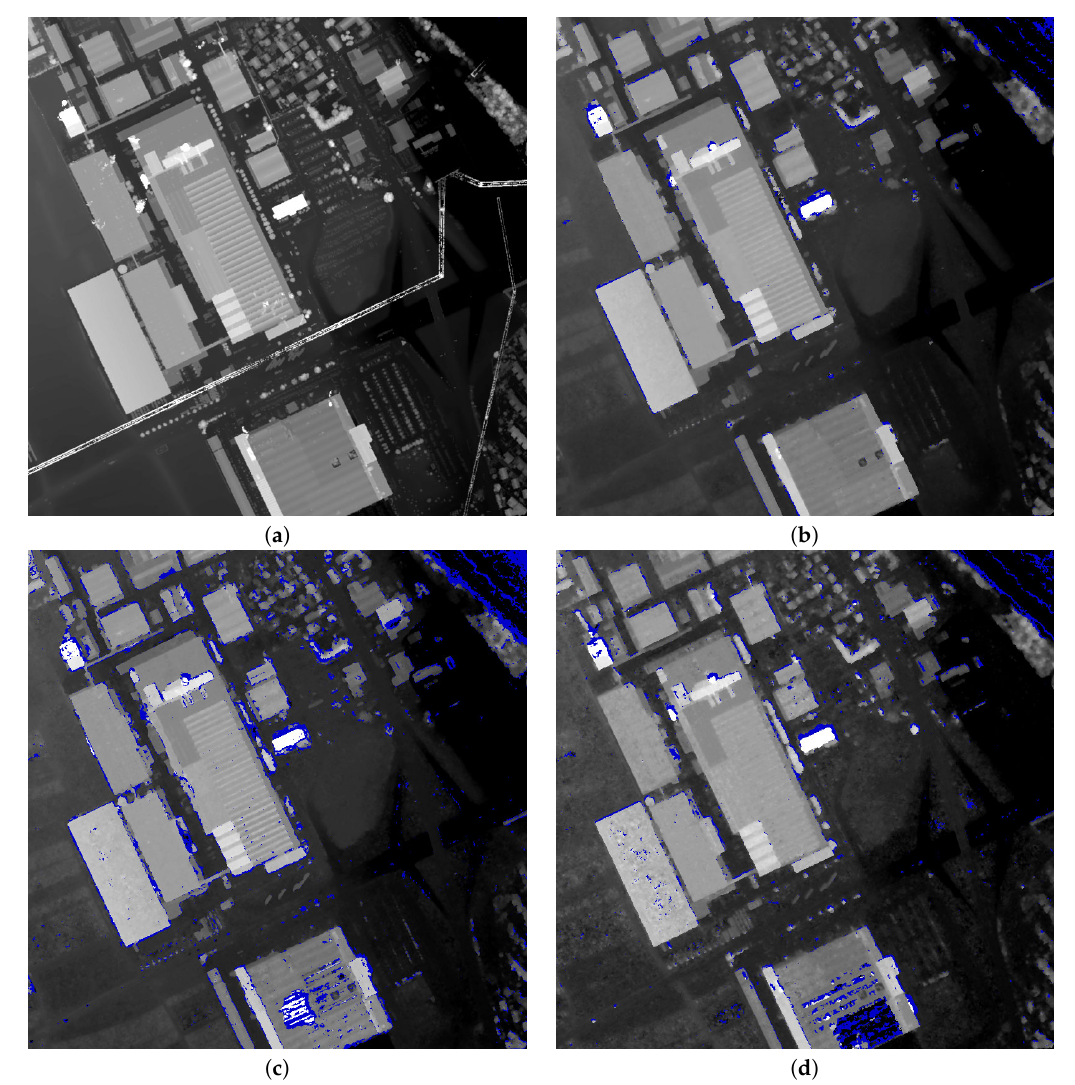
Figure 24. Selected DSM subsets with 800 × 800 m 2 and 1 m GSD of the Ljubljana test site. Height ranges from 410 m to 500 m. Shown are ( a ) LiDAR reference, ( b ) Pléiades DSM based on all stereo pairs with convergence angles in the range of 20 ◦ to 30 ◦ , ( c ) Pléiades DSM based on stereo pair 1–2 and ( d ) Pléiades DSM based on stereo pair 1–3. Dark blue pixel indicate non-reconstructed